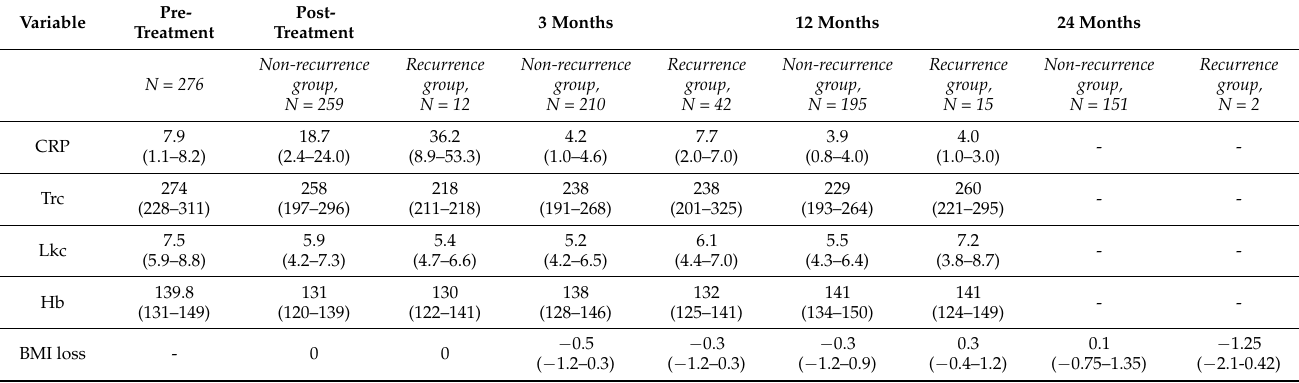
Table 3. Median differences in covariates between the recurrence and non-recurrence groups (where each group is defined by recurrence occurring or not recurring before the next follow-up